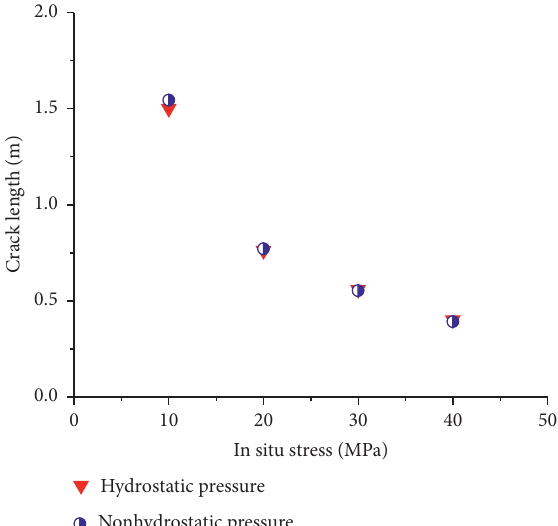
Figure 14: Comparison of crack lengths between the situations of hydrostatic pressure and nonhydrostatic pressure ( σ